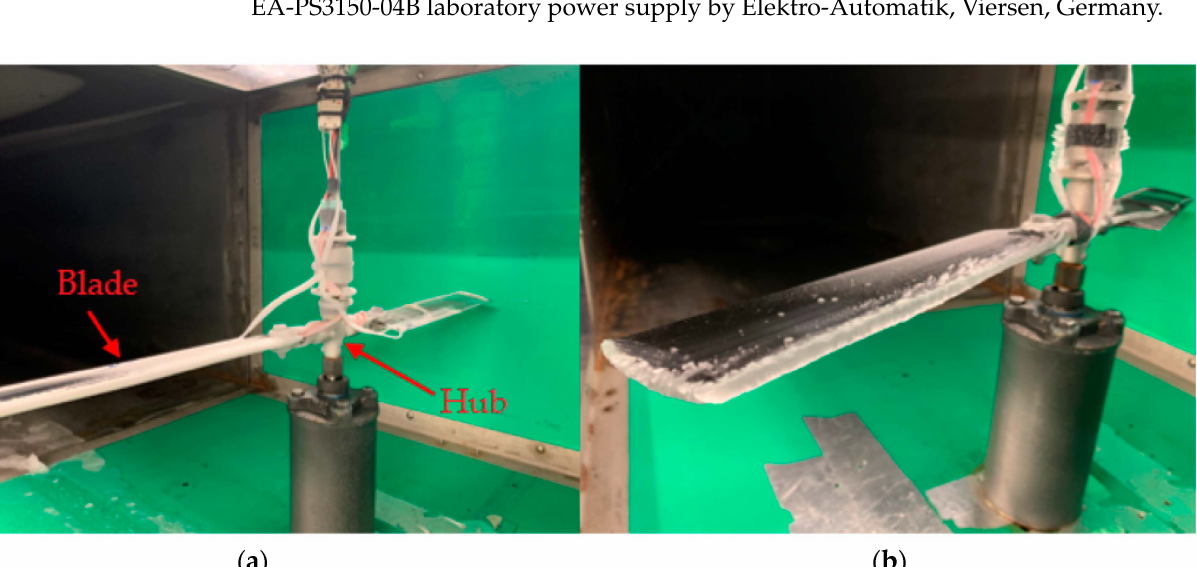
Figure 3. Sprinkler ramp.